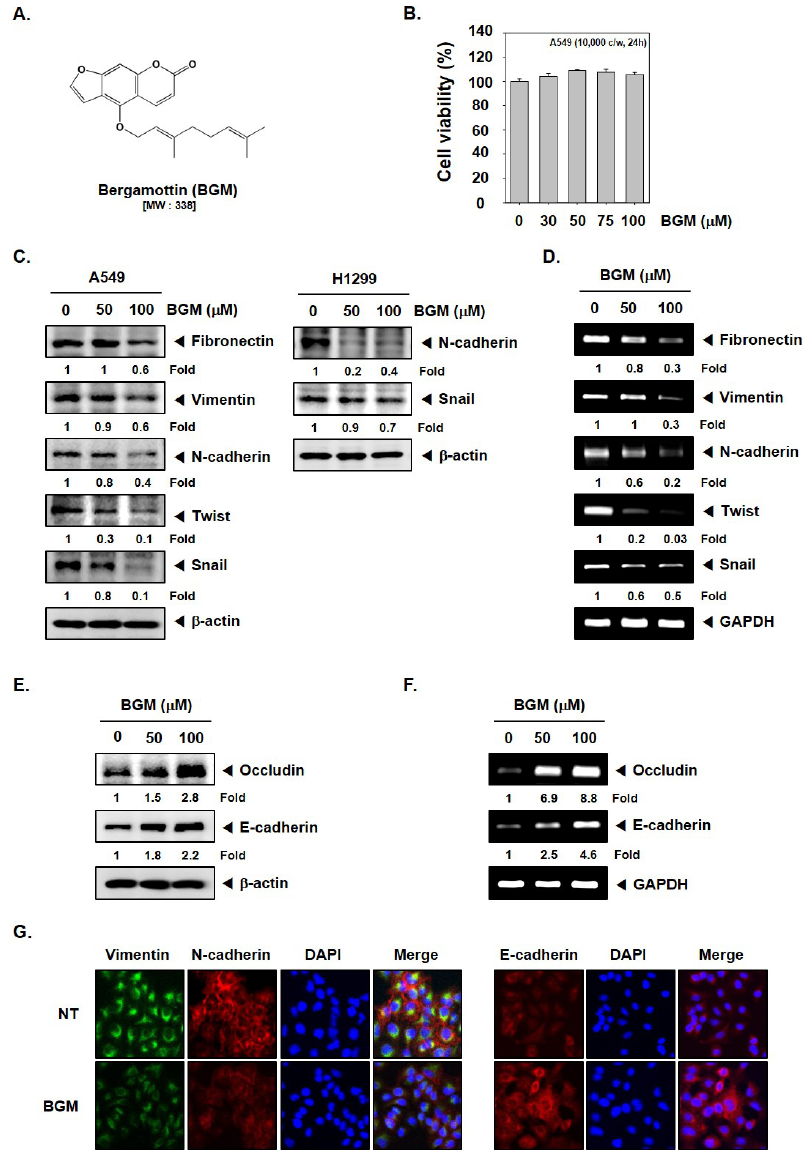
Figure 1. Effects of bergamottin (BGM) on epithelial-to-mesenchymal transition (EMT) in lung cancer cells. ( A ) Chemical structure of BGM. ( B ) A549 cells were treated with BGM (30–100 μM) for 24 h and cell viability was determined by MTT assay. ( C , E ) A549 and H1299 cells were treated with BGM and Western blot analysis was performed using various antibodies as indicated above. ( D , F ) A549 cells were treated with BGM for 24 h and RT–PCR was performed using different primers as indicated above. Band intensities were estimated by the Image J software (version 1.43u, National Institutes of Health, Bethesda, MD, USA). ( G ) A549 cells were treated with 100 μM BGM for 24 h and immunocytochemistry was performed using three different antibodies as depicted above.